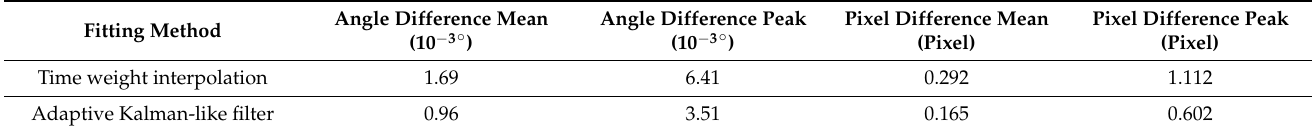
Table 2. Estimated error results after processing by different algorithms.